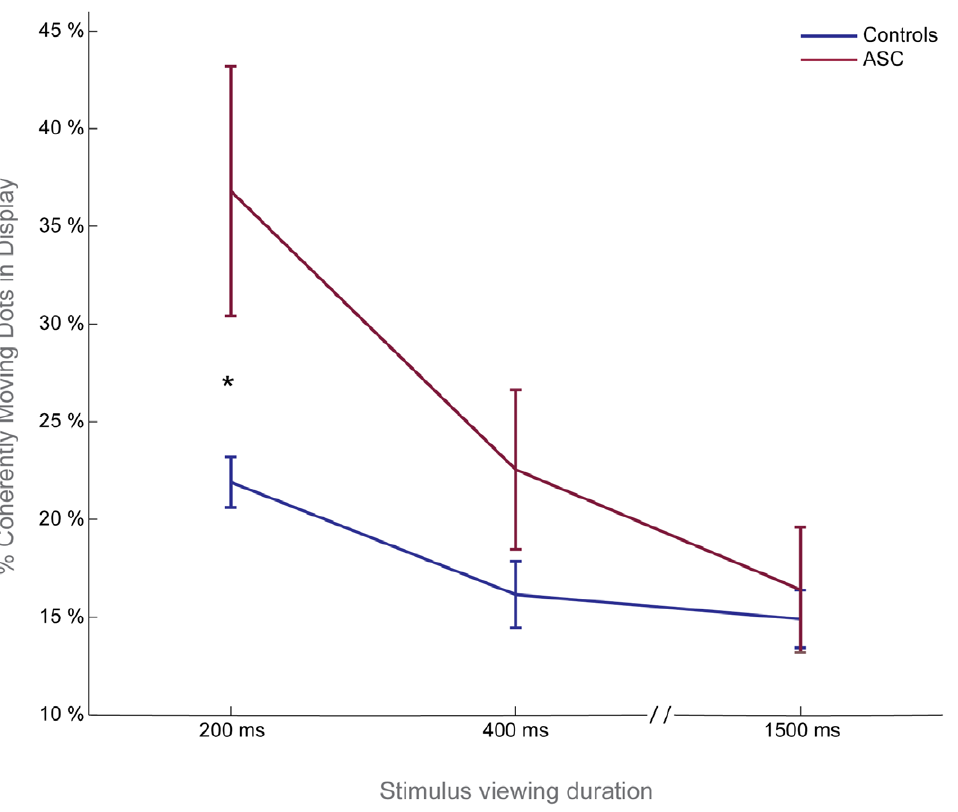
Figure 3. Coherent motion perception deficit in ASC as viewing duration is limited. Group coherent motion perception thresholds ( + / 2 1 SE) are shown here. Coherent motion perception thresholds are significantly elevated in ASC at the 200 ms viewing duration. Longer viewing durations restore coherent motion perception, pointing towards atypical accumulation of motion signals in ASC.